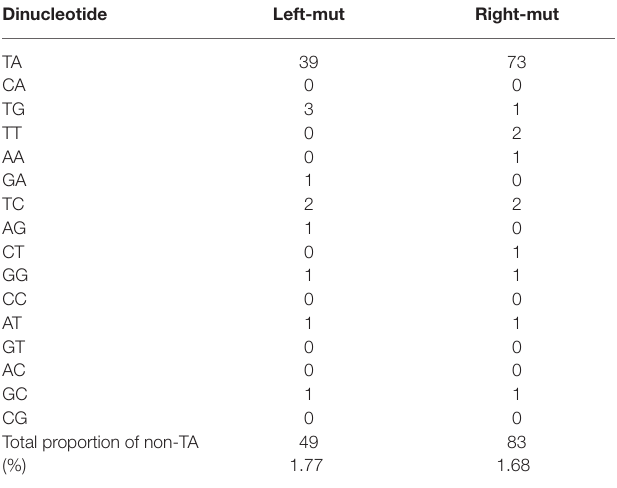
TABLE 2 | Number of integrations at different dinucleotides.